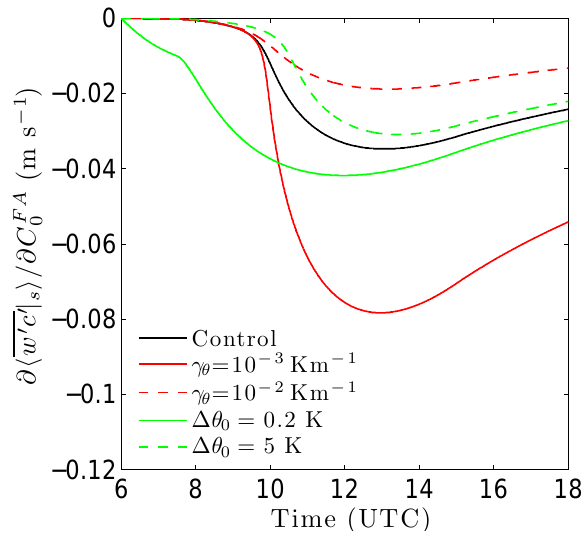
Fig.8. TimeevolutionofthesensitivityofinferredsurfacefluxofCO 2 toinitialvalueoftheCO 2 mixingratiointhefreeatmosphereforthe Fig. 8. Time evolution of the sensitivity of inferred surface flux of sameboundarylayerspresentedinFig. 3. CO 2 to initial value of the CO 2 mixing ratio in the free atmosphere for the same boundary layers presented in Fig.